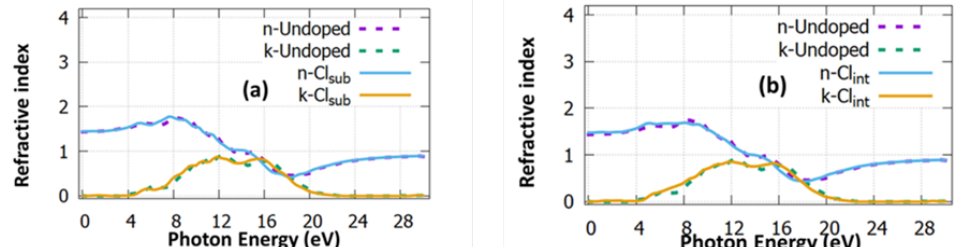
Figure 4. The refractive index of ( a ) Cl Sn : SnO 2 and ( b ) Cl i : SnO 2 .